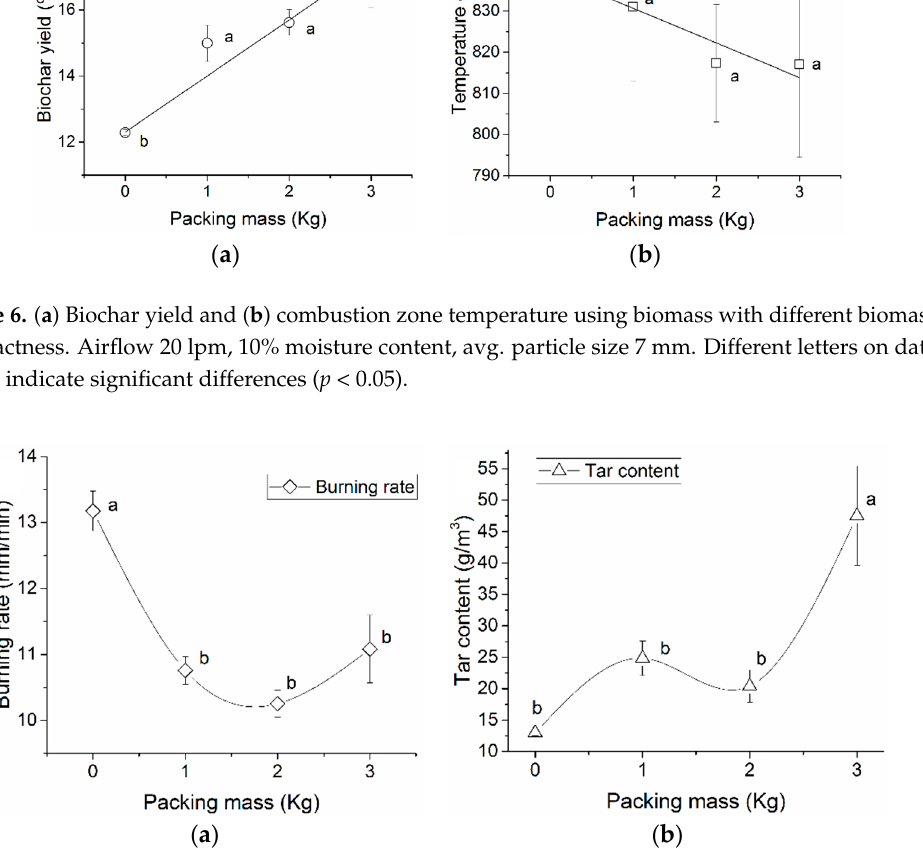
Table 4. Syngas composition and higher heating value at varying biomass compactness (airflow 20 lpm, 10% moisture content, avg. particle size 7 mm). Biomass Compactness (kg)